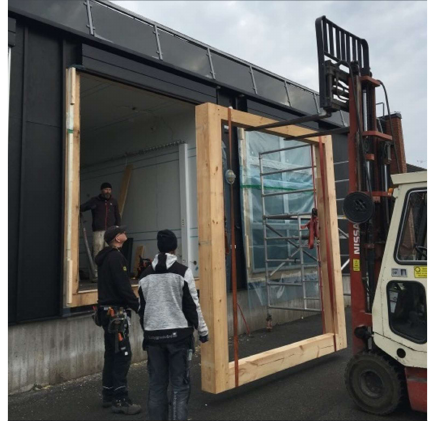
Figure 4. The post-and-beam structure is lifted into place.